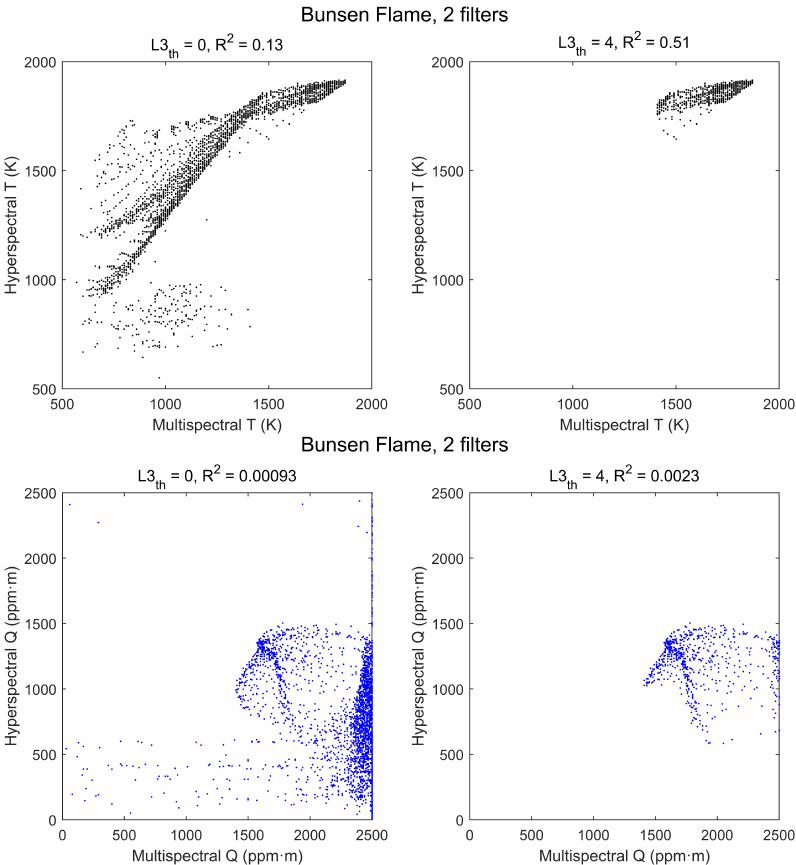
Figure 15. Scatterplots of hyperspectral vs. multispectral retrieved values of T ( top row ) and Q ( bottom row ) for the Bunsen flame, using only filters 1 and 3 for retrieval. Each point corresponds to a pixel, with no radiance threshold ( left column ) and with threshold L3 th = 4 W/m 2 · sr · cm − 1 ( right column